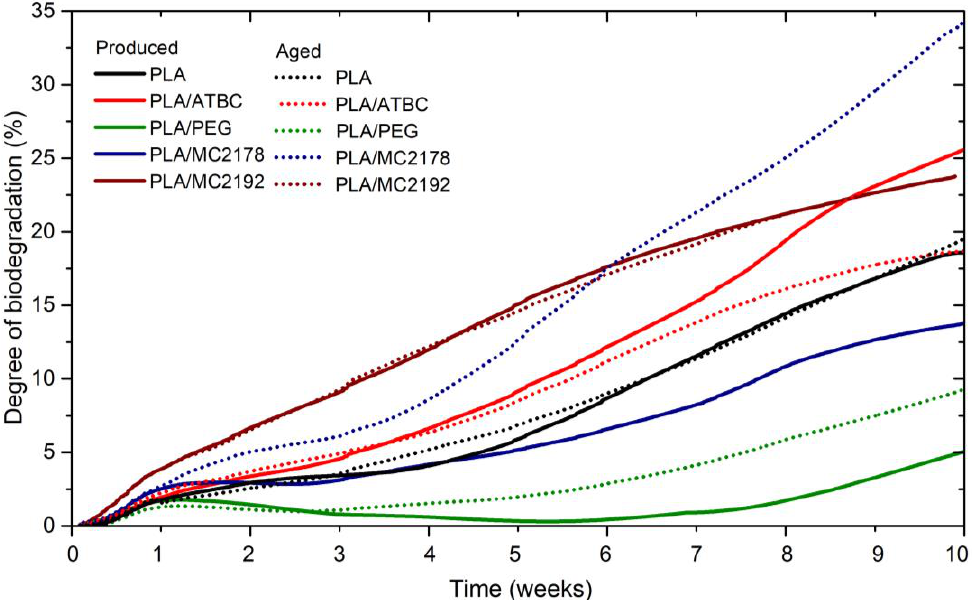
Figure 20. Biodegradation curves of as produced and aged PLA films under controlled thermophilic composting ISO 18455-1.